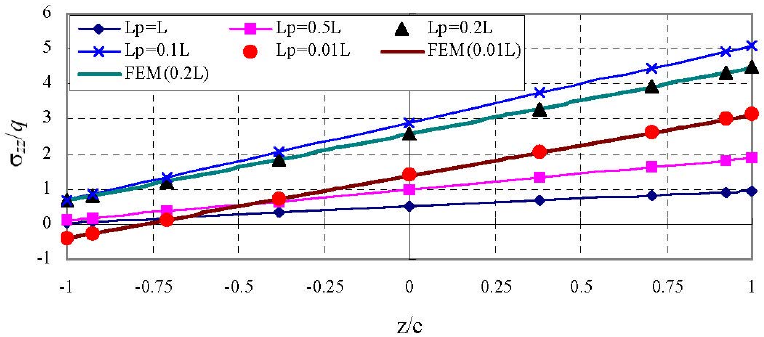
q ) of sandwich panels at x = − 0.0464 L. zz